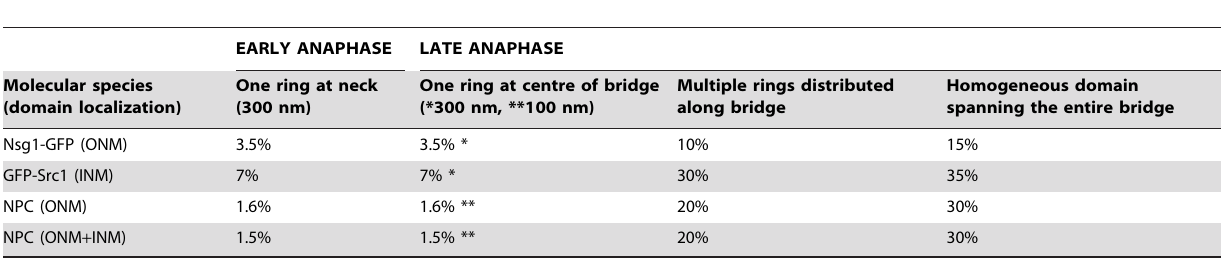
Table 1. Estimated P in values for membrane proteins in different specialised lipid domain